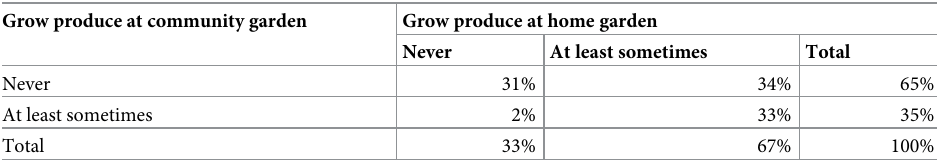
Table 2. Correlation analysis of home and community gardening. Grow produce at community garden Grow produce at home garden Never At least sometimes Total Never 31% 34% 65% At least sometimes